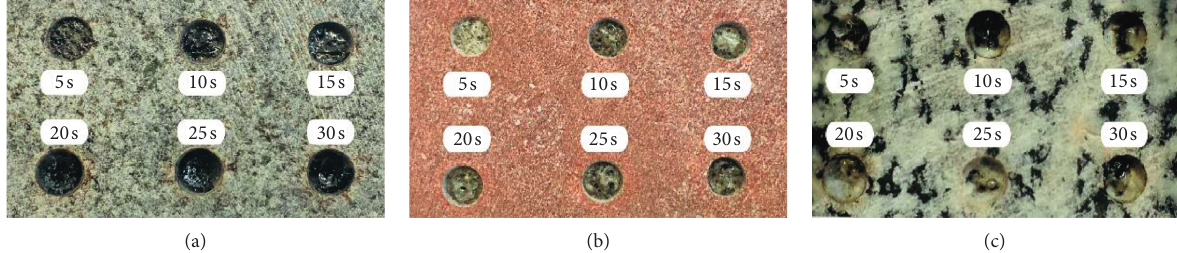
Figure 7: The morphologies of laser perforated rock under different laser irradiation time. (a) Basalt. (b) Sandstone. (c)